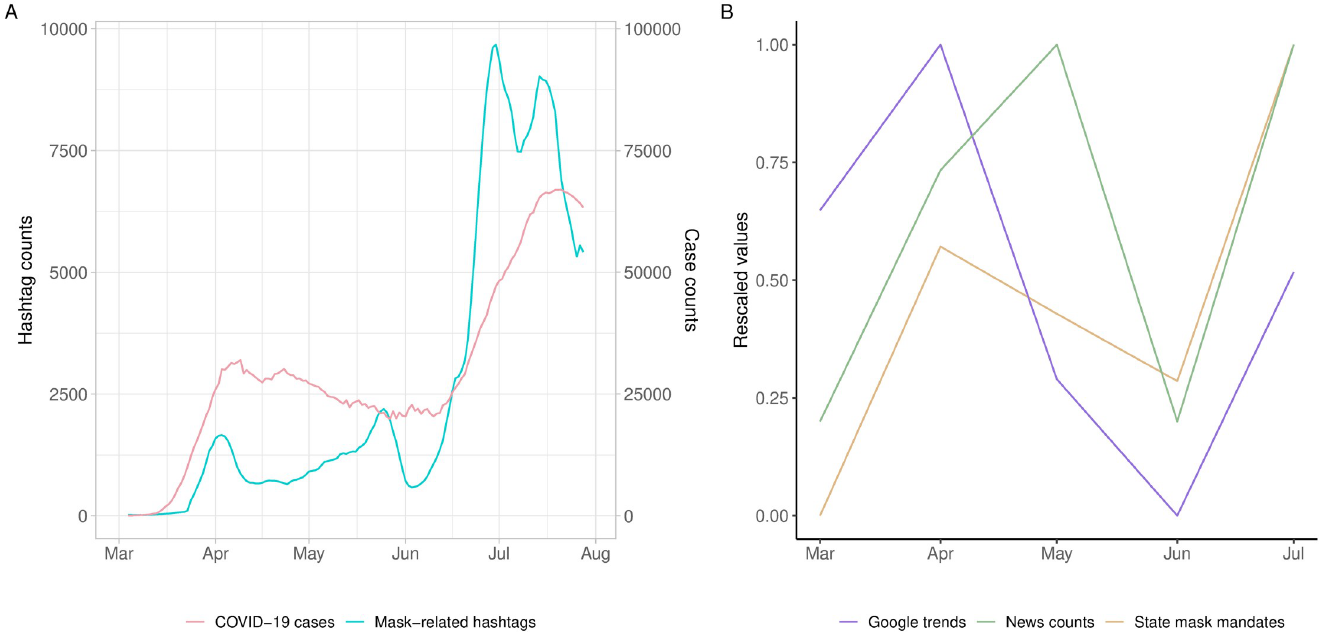
Fig 8. (A) Mask-related hashtag counts and daily confirmed COVID-19 case counts in the U.S. from early March to the end of July 2020. The figure plots the trends of mask-related hashtags on the left y-axis and the trajectory of daily confirmed COVID-19 cases on the right y-axis using seven-day moving averages for the two data series. (B) Three temporal trends from early March to the end of July 2020: (1) monthly statewide mask mandates, (2) monthly Google Trends searches for “face mask,” and (3) monthly high-profile mask-related news headlines. The volume of each temporal trend is rescaled from 0 to 1 for the ease of